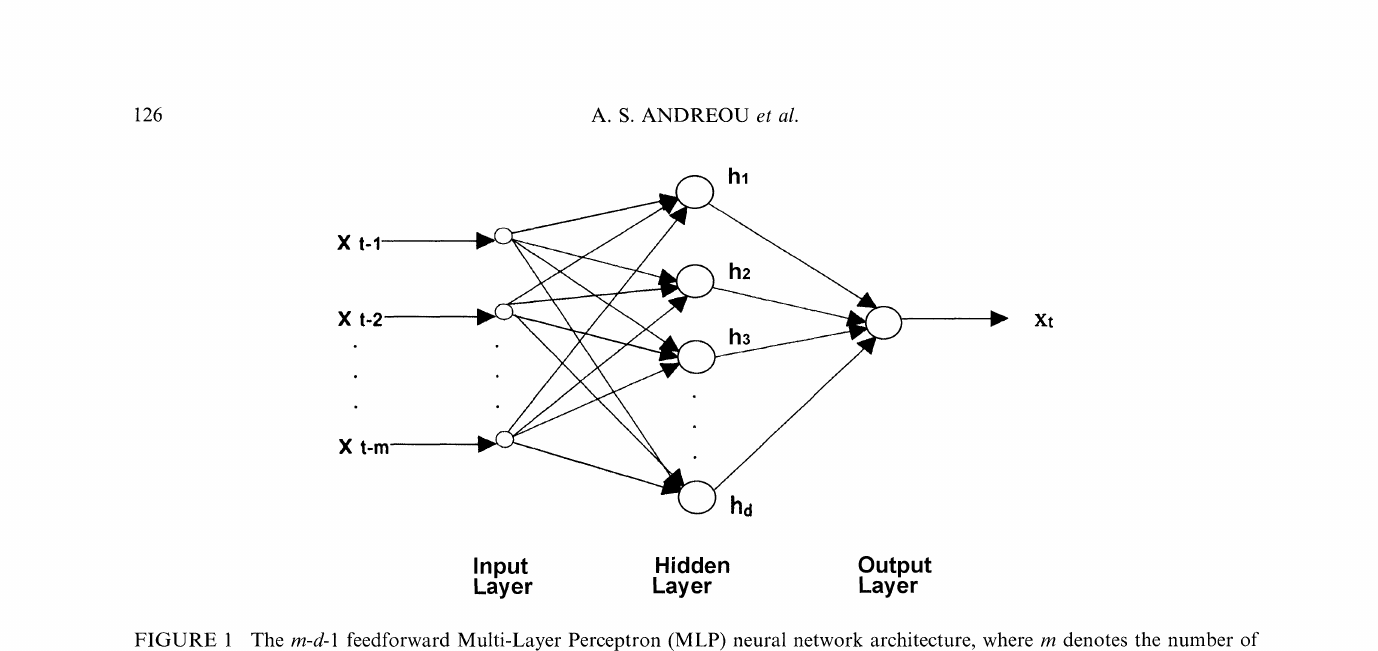
FIGURE The m-d-1 feedforward Multi-Layer Perceptron (MEP) neural network architecture, where m denotes the number of inputs and d the number of hidden